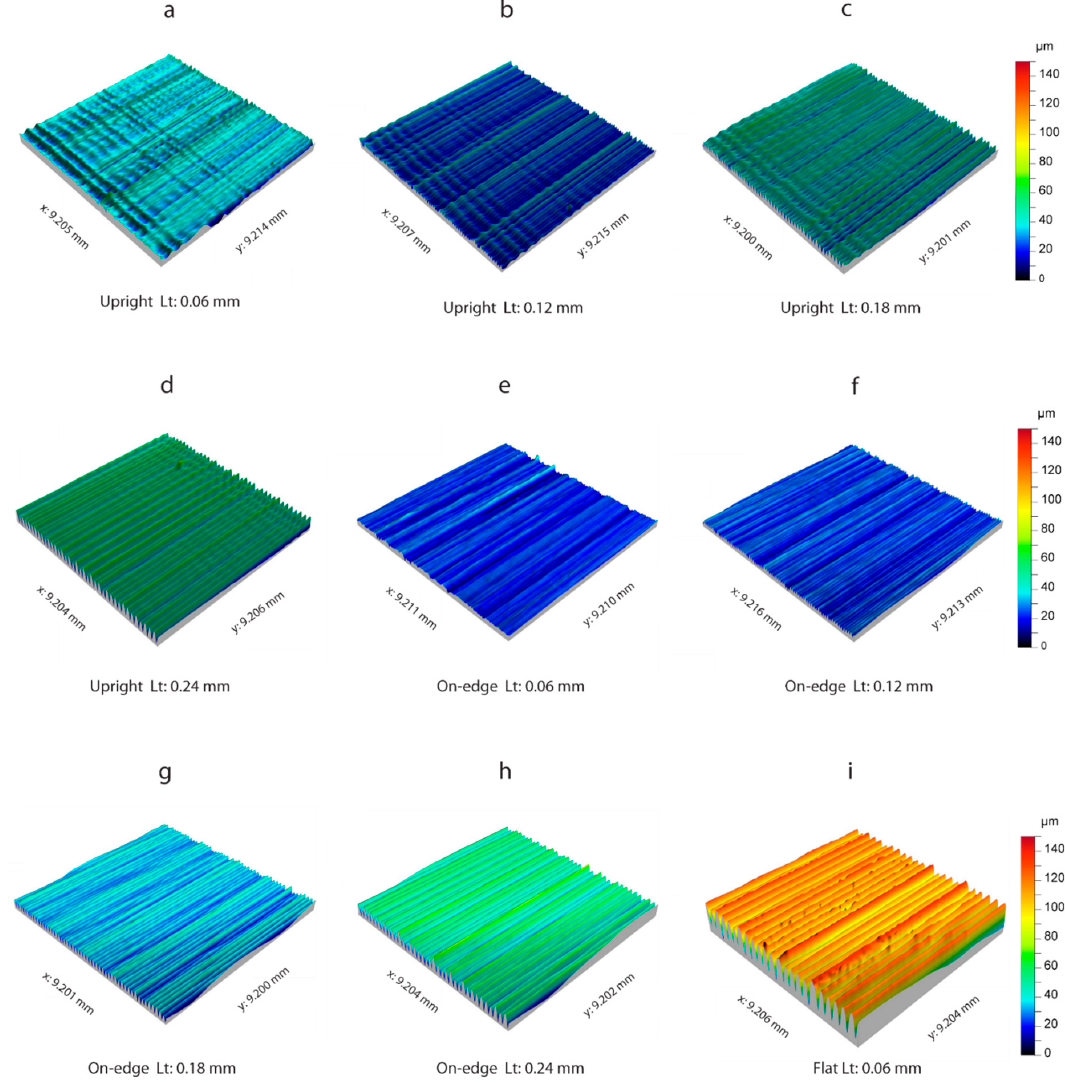
Figure 13. Detail of surface roughness obtained in the three build orientations: Upright ( a, b, c, d ), on-edge ( e, f, g, h ), and flat ( i ).